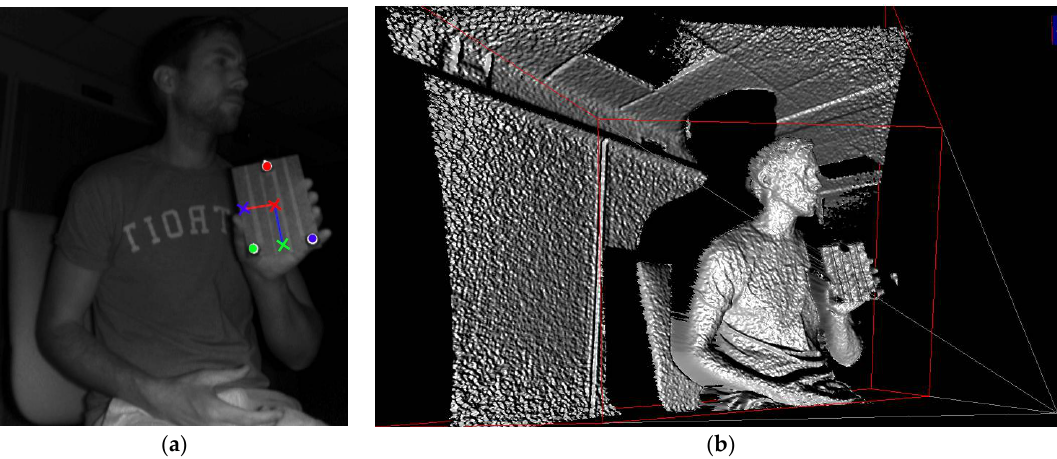
Figure 1. ( a ) Infrared image allows retro-reflective marker tracking due to pixel saturation (tracked markers highlighted by red, green and blue circles); ( b ) corresponding three-dimensional